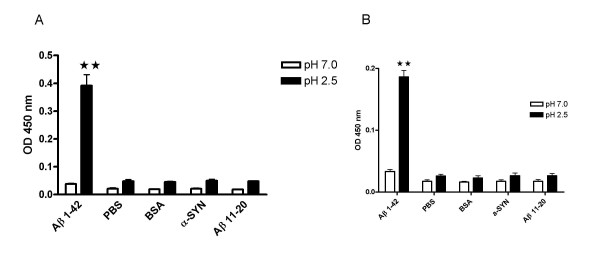
Incubation at pH 2.5 induced increase in anti-Aβ ELISA signal is present not only in sera from vaccinated mice, but also untreated mice. Sera were collected from APP transgenic mice vaccinated (Vax +) with Aβ1–42 (panel A) and nonTg unvaccinated (Vax -) mice (panel B; normal serum), preincubated with dissociation buffer at either pH 7 (open bars) or pH 2.5 (solid bars) at room temperature for 20 minutes and centrifuged through 10,000 MW filters, brought to neutral pH and reconstituted to the original serum dilution volume. The sera were then incubated on ELISA plates coated with one of the following at 5 μg/ml; human Aβ1–42, phosphate buffered saline (PBS; a "no protein" control), bovine serum albumin (BSA), recombinant alpha-synuclein (a-SYN) or Aβ peptide amino acids 11–20. ELISA assays were completed as described in methods and the optical density (OD) at 450 nm used to estimate the amount of antibody binding to the ELISA plate. Note different Y-axis scales in panels A and B. Results are presented as mean ± SEM. ** P < 0.001 compared to pH 7.0.